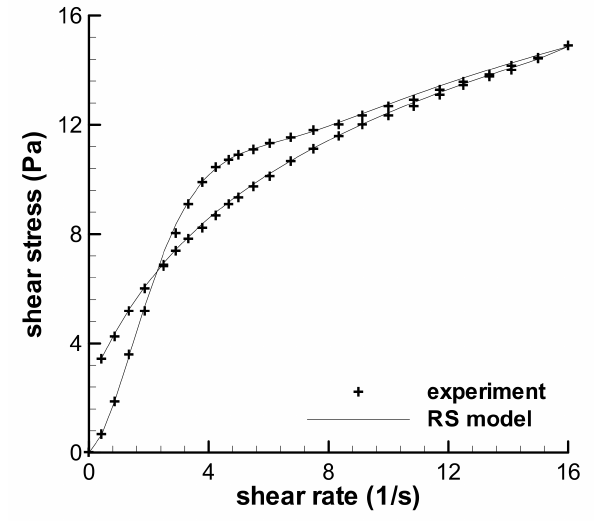
Figure 4. The prediction of the triangular-loop experiment with the maximum shear rate of 16 s − 1 and the t 0 of 10 s, and the experimental data given by Greener and Connelly [36].